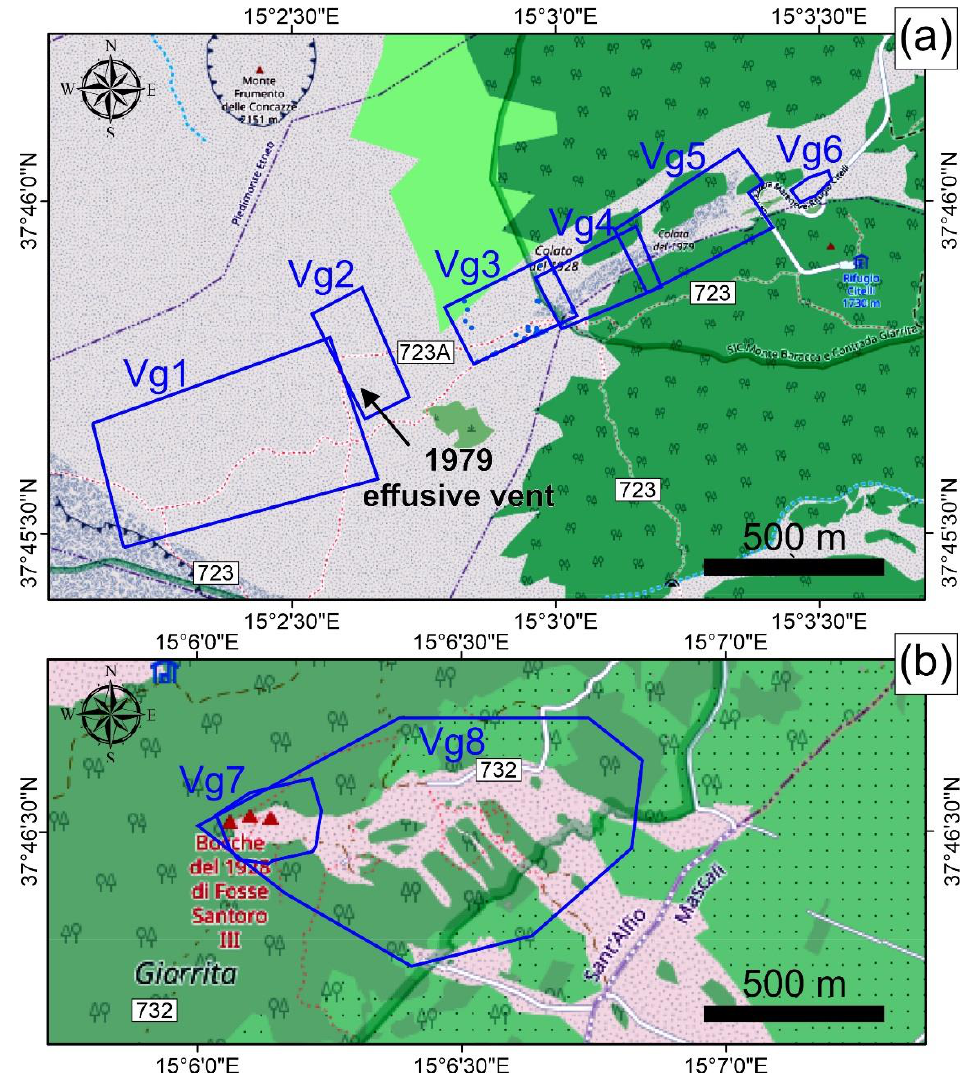
Figure 2. ( a ) Map displaying the location of the virtual geostops along the upper geotrail; the hiking paths that are available in the upper part of the geotrail are also shown (nos. 723 and 723A) and begin from the Rifugio Citelli. ( b ) Map showing geostops 7–8, located in the locality “Giarrita”, along trail no. 732. Map data © OpenStreetMap contributors, CC BY-SA, https://www.openstreetmap.org/ (accessed on 26 January